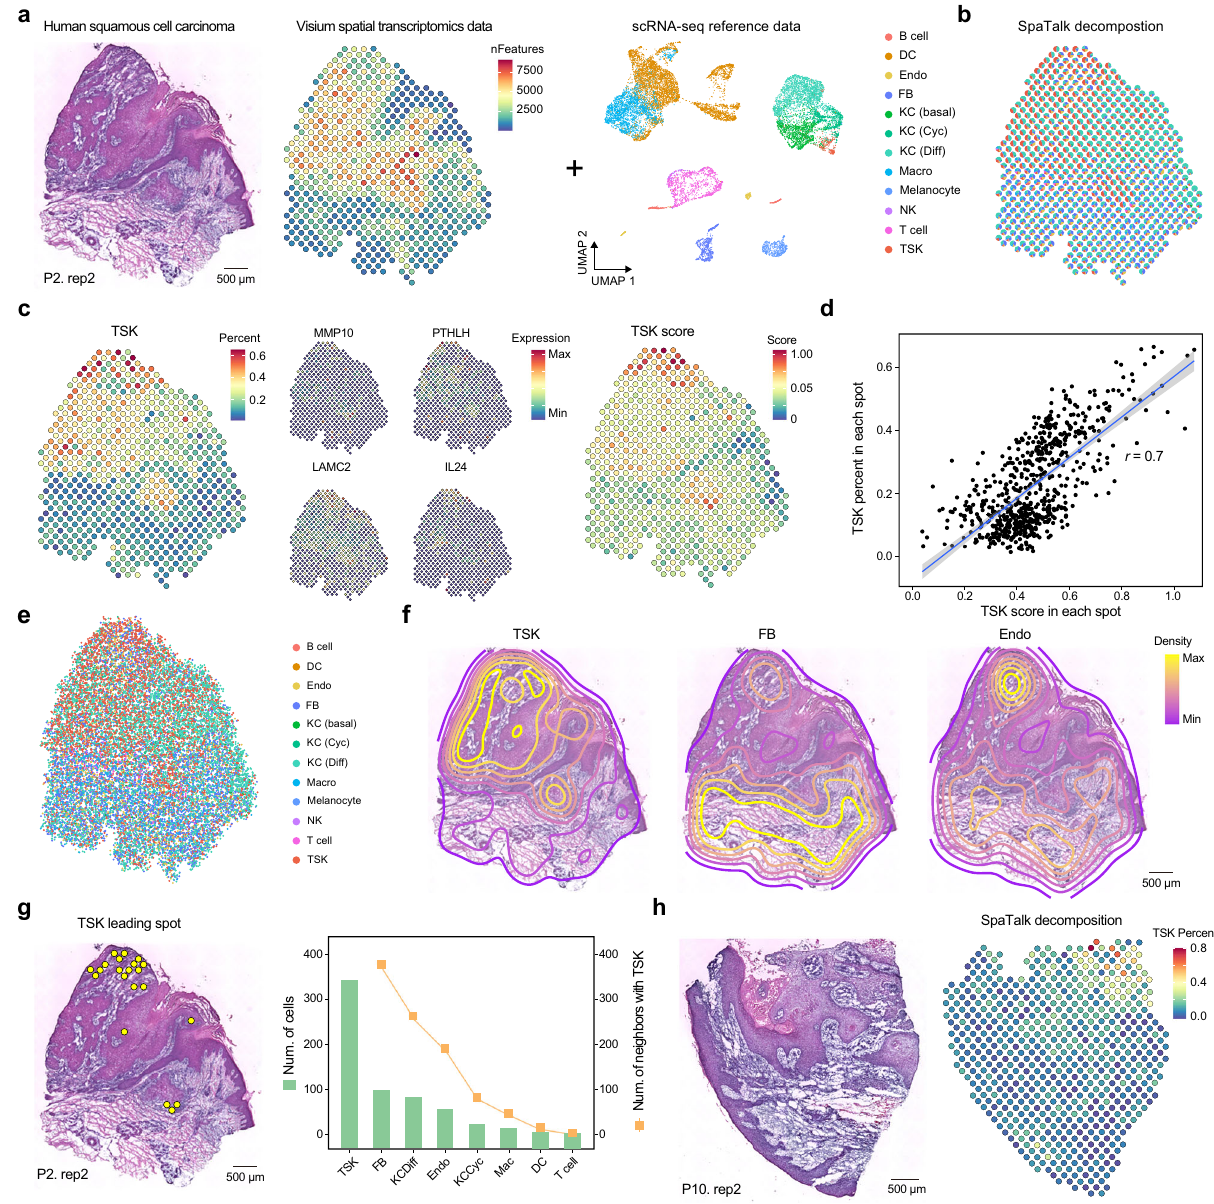
Fig.5|Spatialcharacterizationoftumorandstromalcellsinhumansquamous cell carcinoma Visium data with SpaTalk. a Visium spot-based ST dataset of human skin SCC in patient 2 with the matched scRNA-seq dataset involving the main keratinocytes (KC), stromal cells, and immune cells. b Cell-type decomposi- tionbySpaTalk.Cyc,cycling;Diff,differentiating;NK,naturalkiller;FB, fi broblasts; TSK, tumor-speci fi c keratinocytes. c TSK percent and TSK score across spatial spots. The expression of known TSK markers is plotted. d Pearson ’ s correlation coef fi cient between the TSK percent and TSK score. The gray band represents the